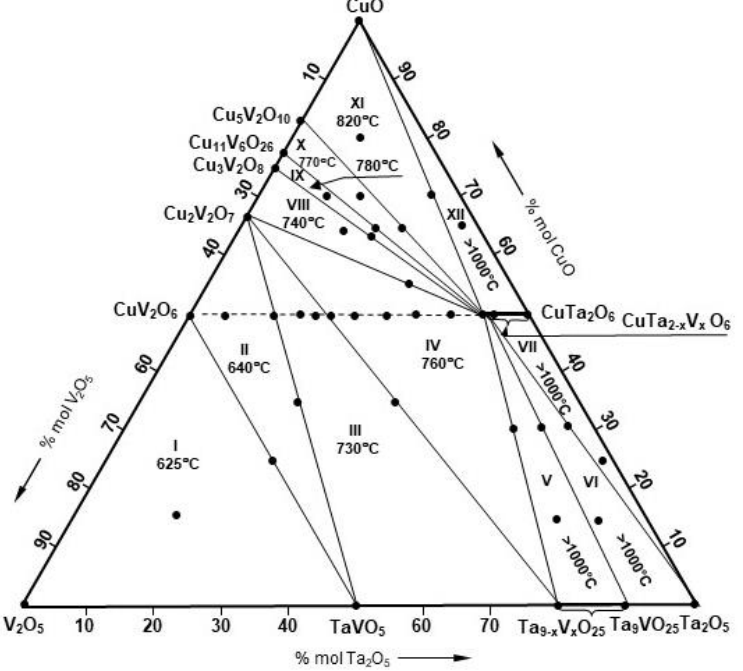
Figure 5. Division of the CuO–Ta 2 O 5 –V 2 O 5 ternary system into partial subsystems. The final verification of the subsolidus area of the CuO–Ta 2 O 5 –V 2 O 5 system